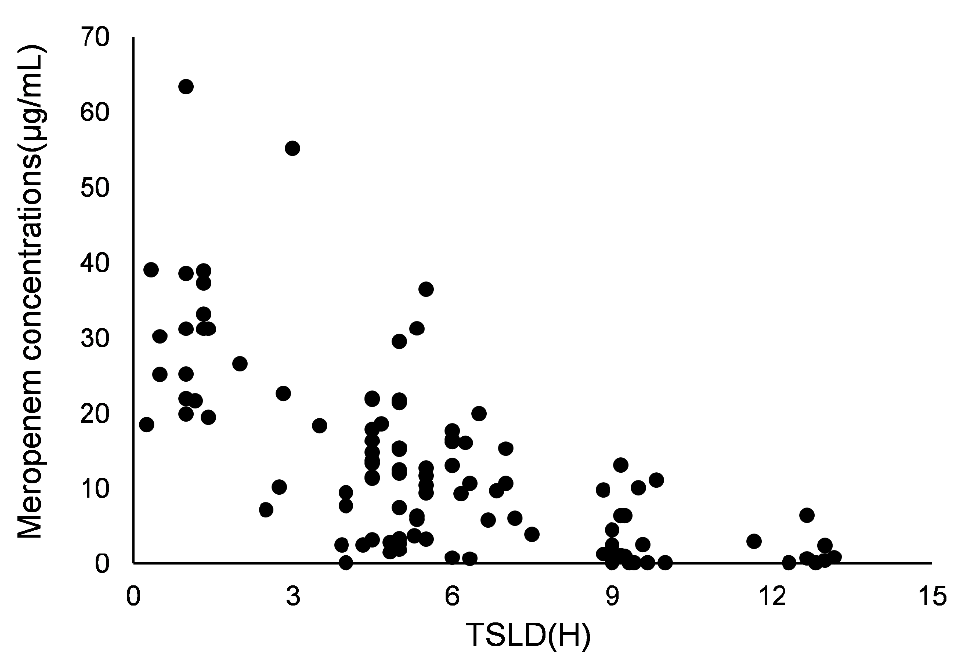
Figure 1. Meropenem concentrations versus time since last dose (TSLD). Table 2. PopPK parameters and bootstrap